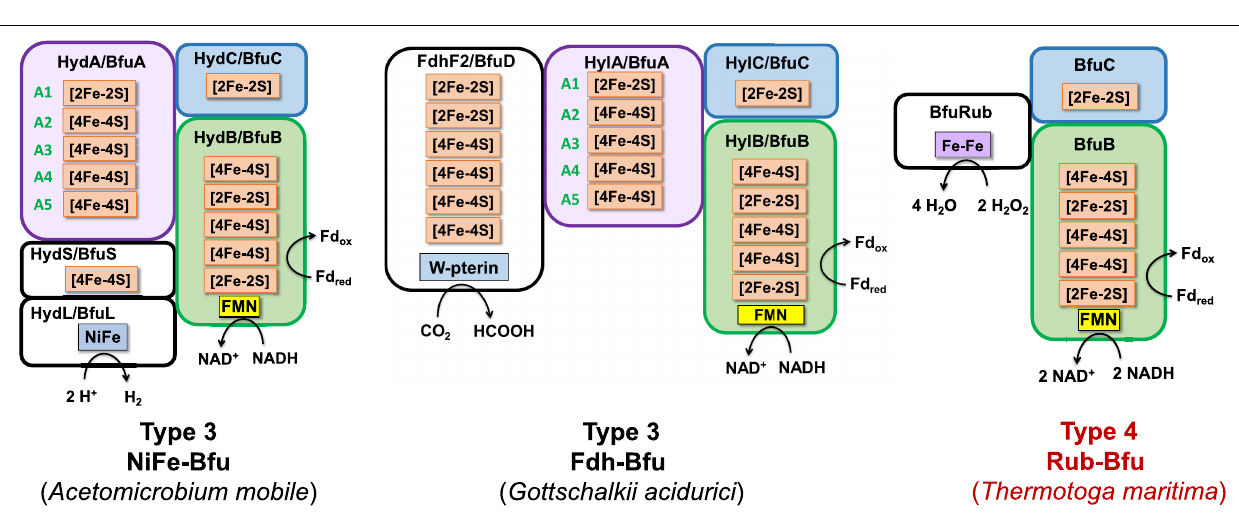
FIGURE 9 | Predicted subunits and cofactor contents of Type 3 and Type 4 Bfu enzymes. Characterized and predicted enzymes and their microbial sources are shown in black and red font, respectively. The Type 3 enzymes contain additional subunits that feed electrons to BfuA from the third substrate and their BfuA subunits contain the A3 and A5 iron sulfur clusters. The Type 4 enzyme lack a BfuA homolog. See text for details.